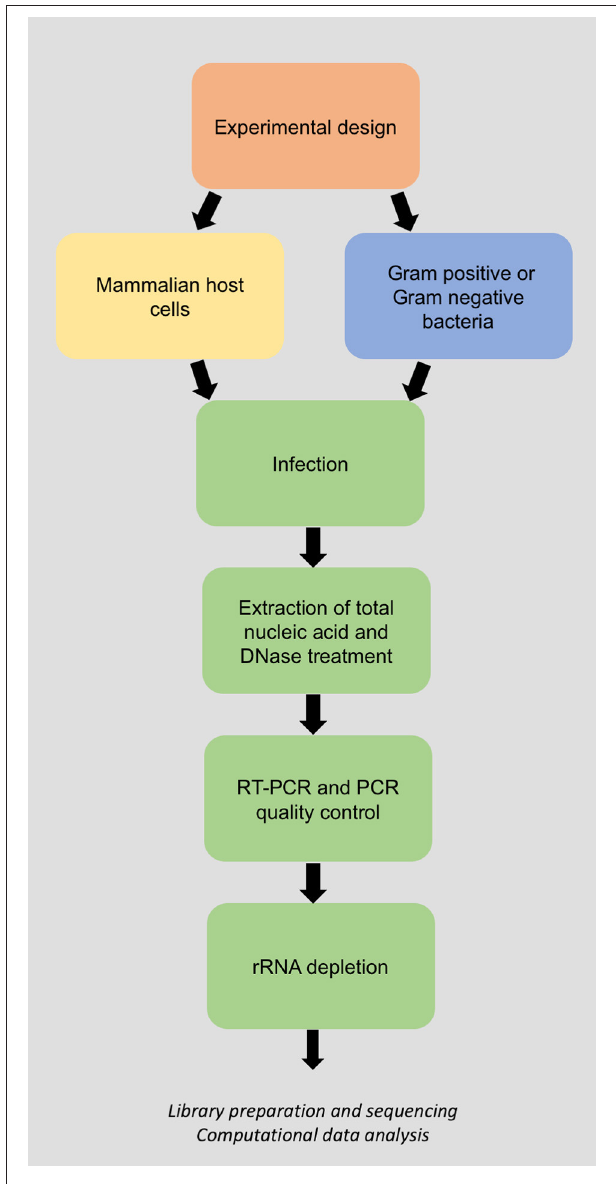
FIGURE 1 | Flow chart of the laboratory methodology for dual RNA-Sequencing of bacteria and their